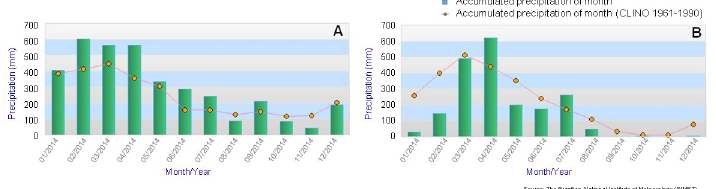
Fig 6. Accumulated precipitation of month X precipitation (CLINO 1961–1990) of the Bele´m (A) and Tracauateua (B)